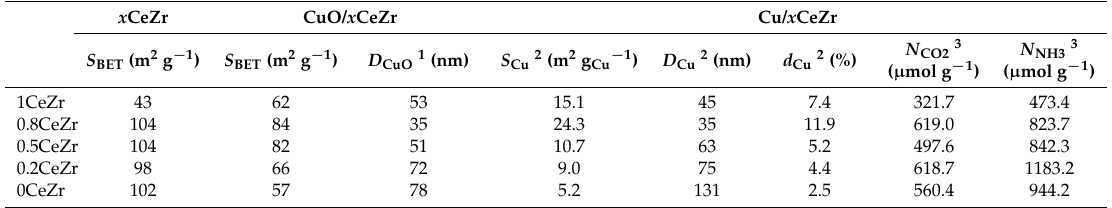
Table 1. Physical and chemical properties of x CeZr, CuO/ x CeZr, and Cu/ x CeZr samples.